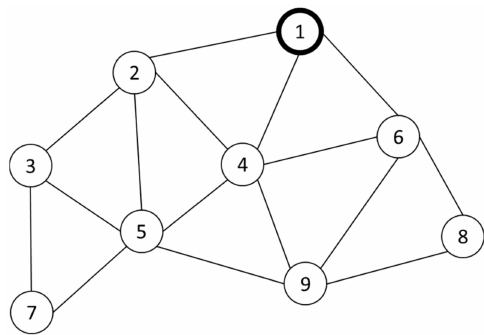
Figure 1. An example of a network